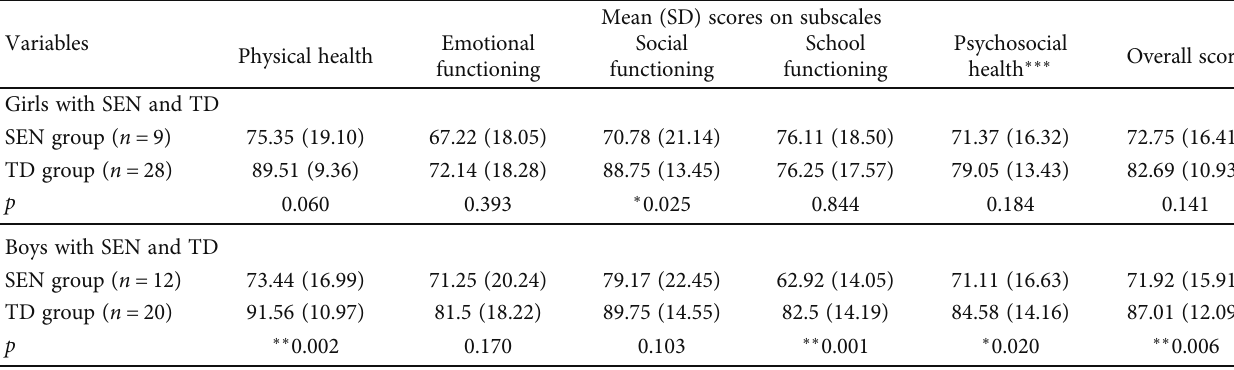
Table 6: Gender comparison of PedsQL between children with SEN and